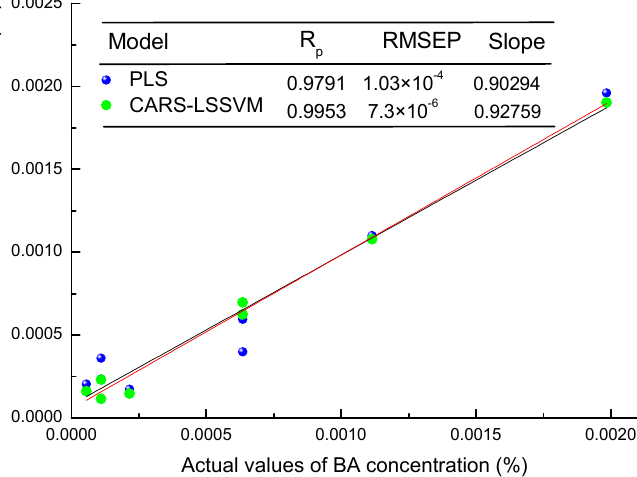
Figure 9. The optimal predictive value effect of PLS and LS-SVM models for benzoic acid concentration in mixed samples.